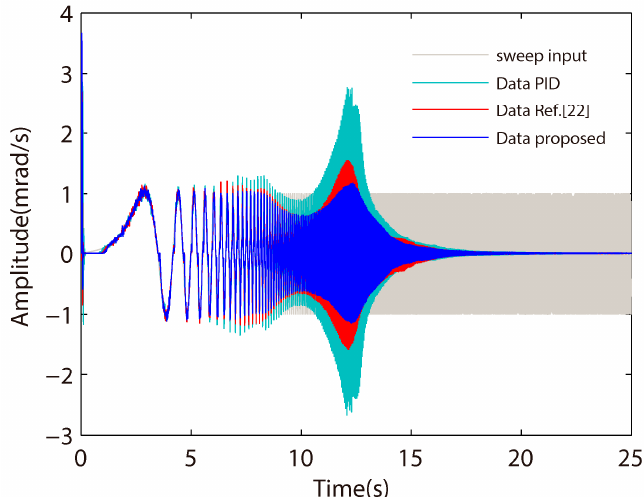
Figure 14. Closed-loop sweep curve of pitch axis. Appl. Sci. 2019 , 9 , x FOR PEER REVIEW